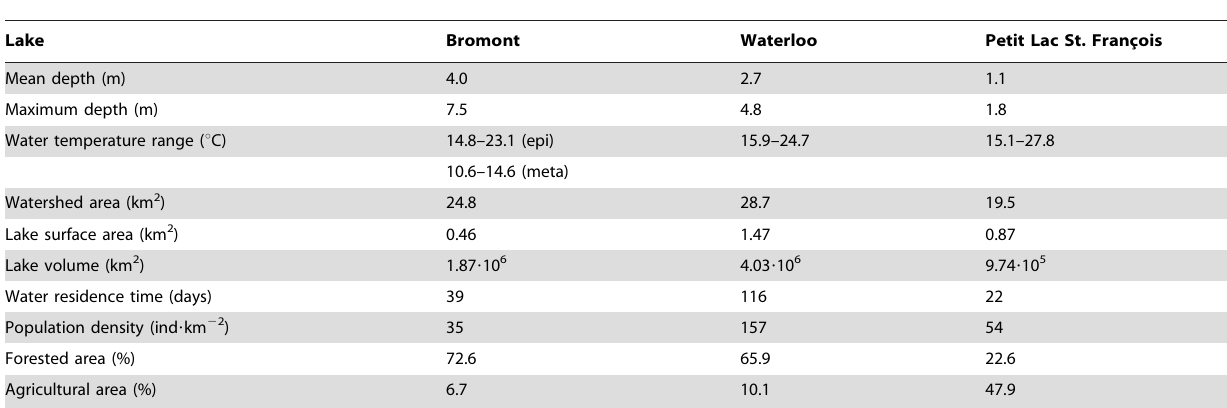
Table 1. Morphological and physical characteristics for the three study